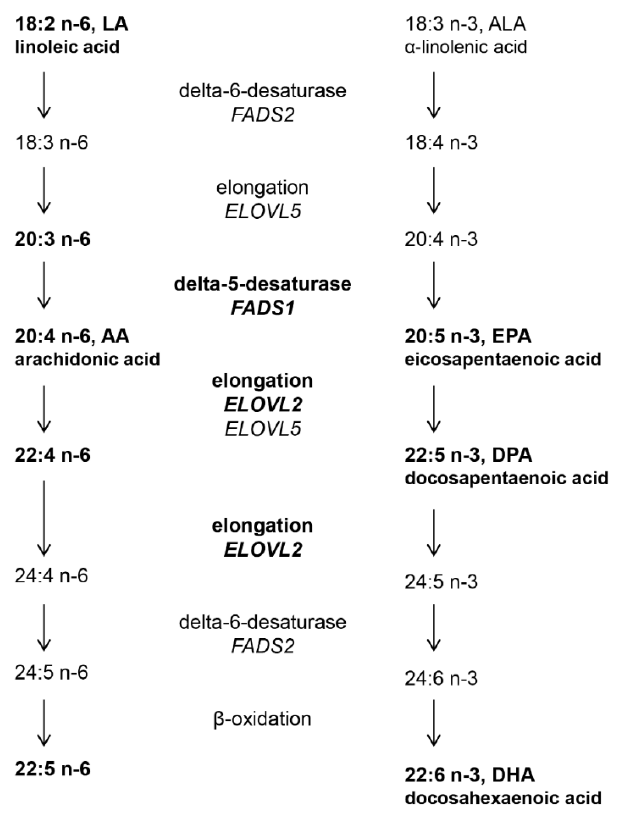
Figure 1. The metabolic pathways of polyunsaturated fatty acids in mammals [26]. Fatty acids and genes in bold were examined in this study.